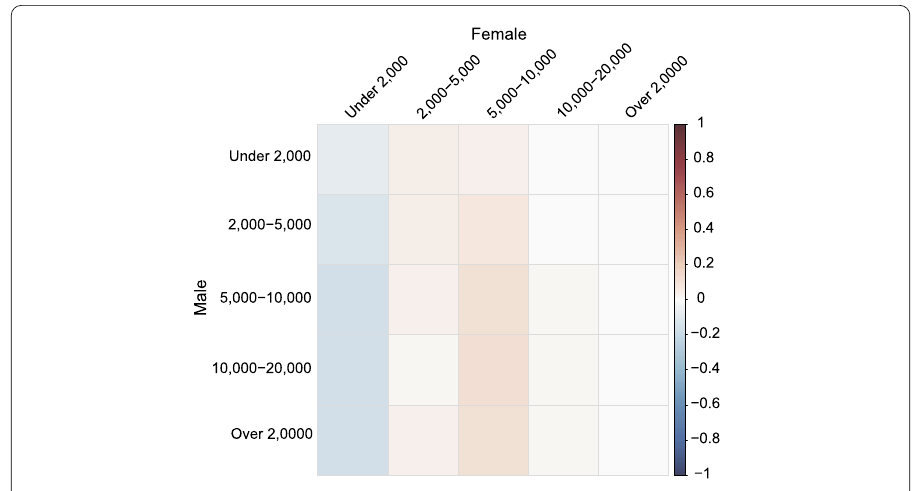
Figure 7 Preference for monthly income levels for male users sending messages to female users. The vertical axis indicates the male income levels and the horizontal axis indicates the female income levels. Preference values are represented by different colors